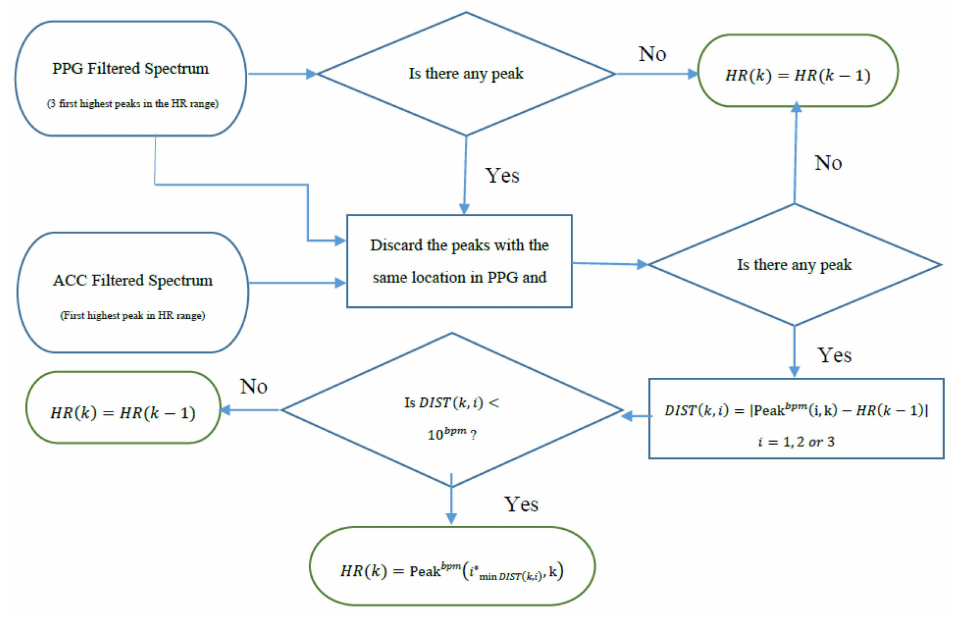
Figure 4. Flowchart of HR tracking and